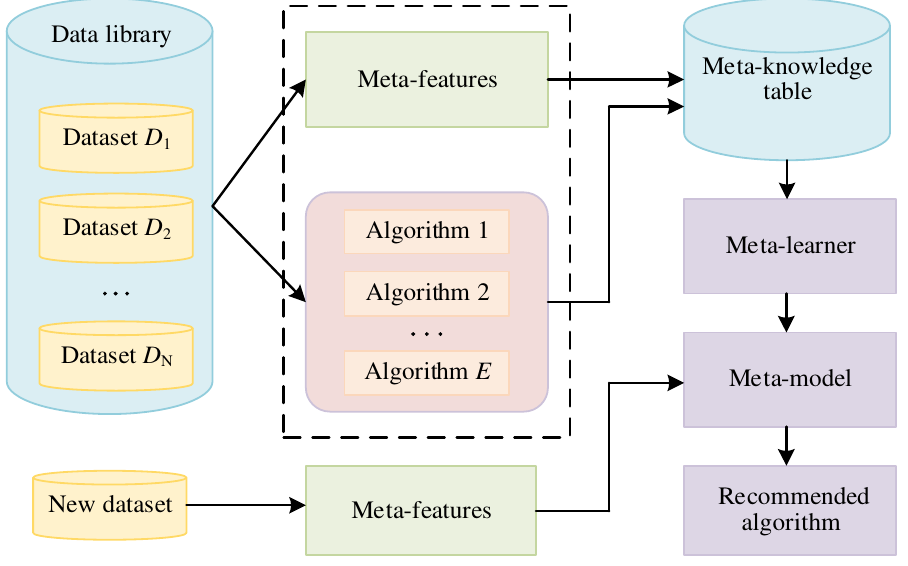
Figure 1. Schematic diagram of meta-learning.